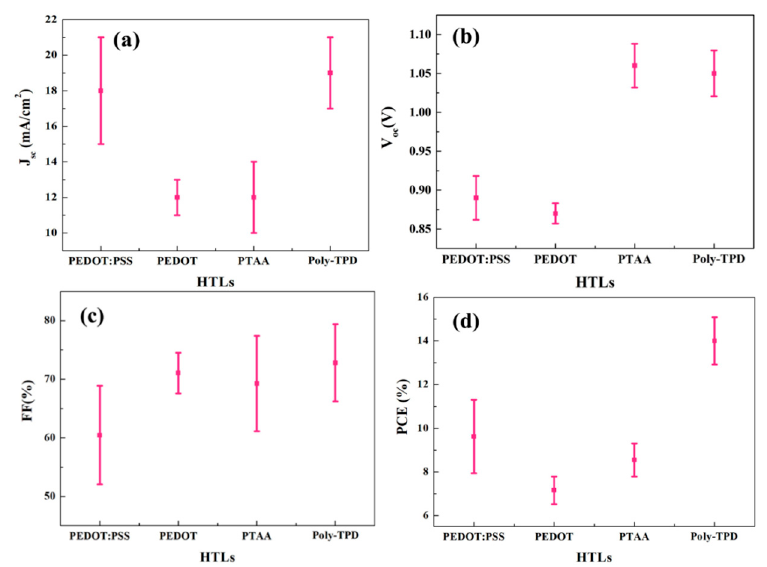
Figure 6. Statistics of photovoltaic parameters, ( a ) fill factors (FF), ( b ) V oc , ( c ) J sc , and ( d ) power conversion efficiency (PCE) for different HTLs.